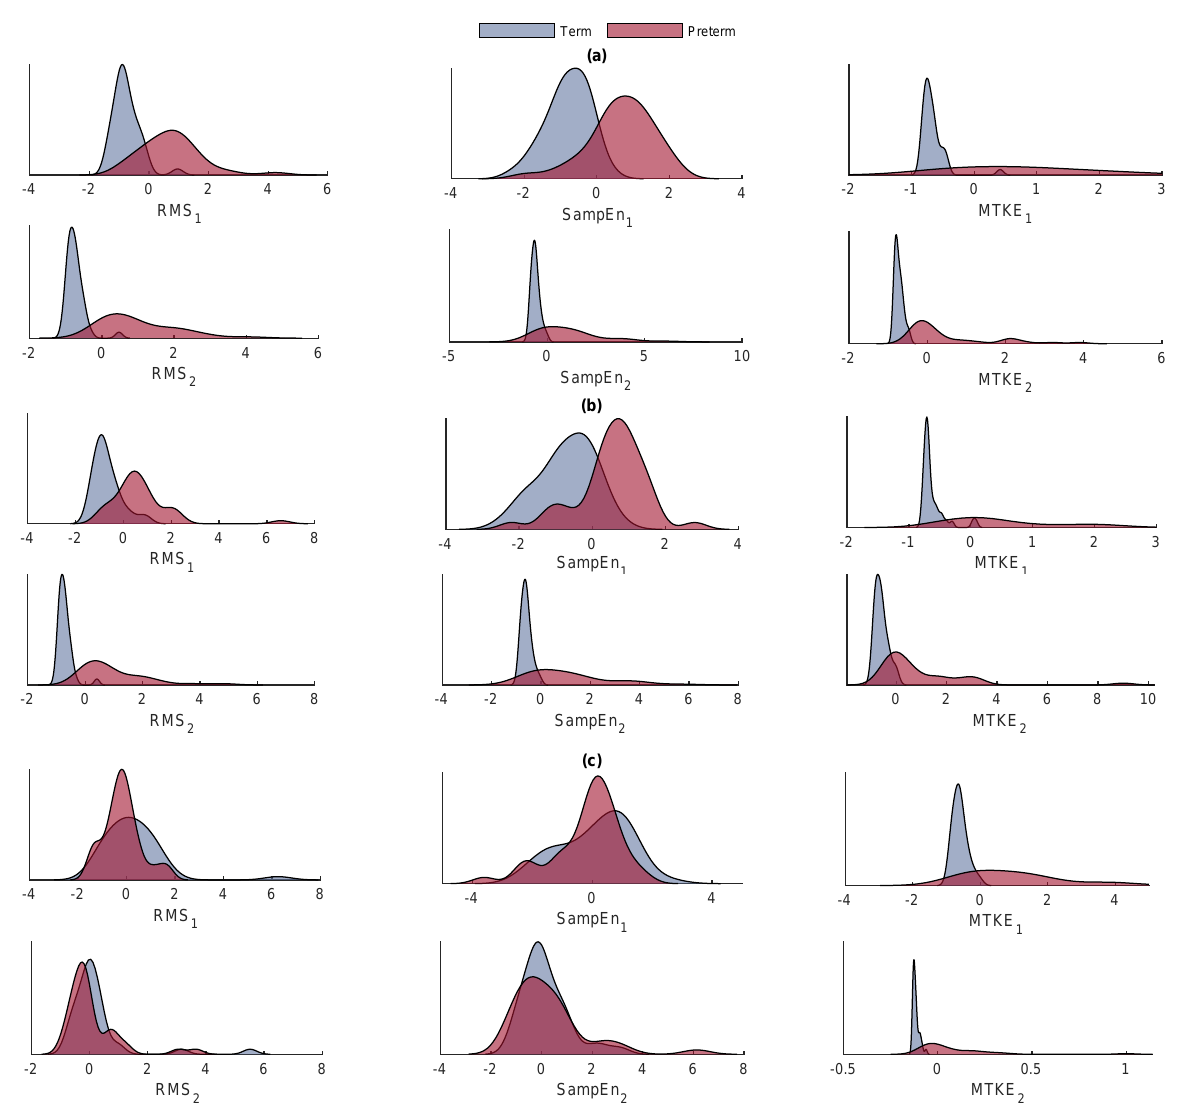
Figure 4. The distribution of the extracted features from IMF1 (first row) and IMF2 (second row) from ( a ) CH 1 , ( b ) CH 2 , and ( c ) CH 3 . Table 2. SVM performance for different channel configurations. The best results are in